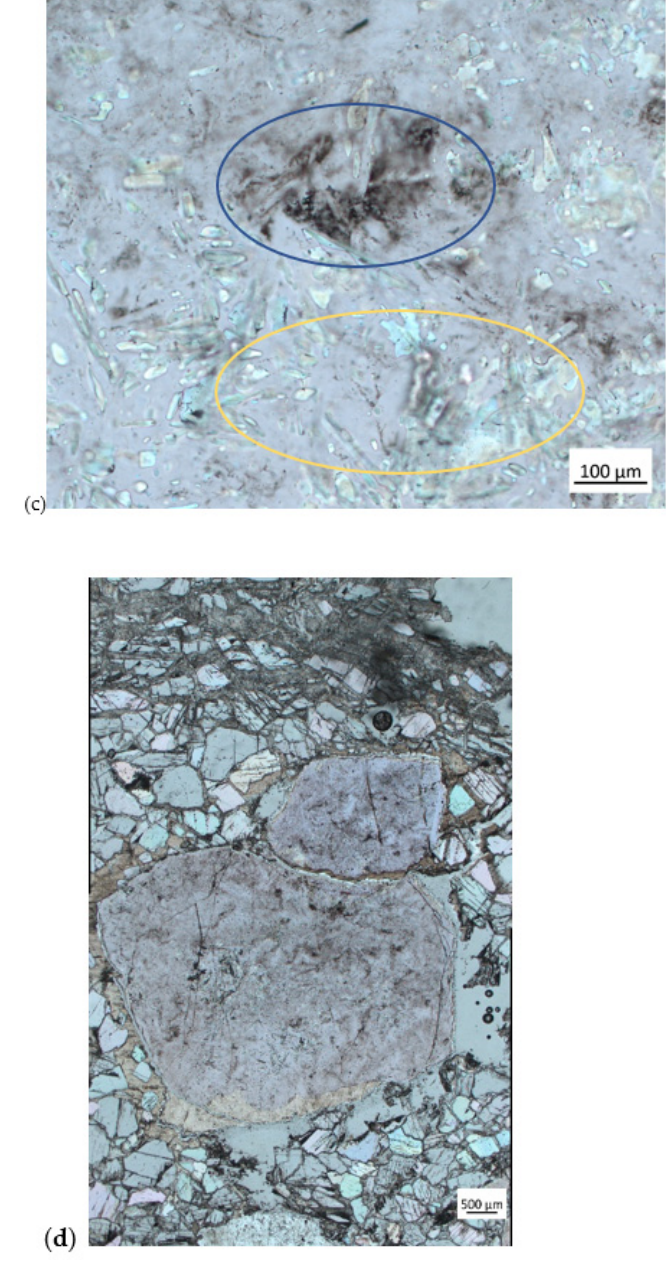
Figure 11. ( a ) petrographic thin section with disordered graphite (red circle), anhydrite (green star), and bukovskyite (orange circle) inclusions incorporated into the quartz. Inside the host rock there are also ( b ) gypsum crystals (blue ovals); ( c ) graphite (blue ovals) and anhydrite (yellow ovals) inclusions clusters (20 × ); and ( d ) dark spots, all of graphite clusters (2.5 × ). In Figure 12 we report the Raman analysis spectra of four points (red color), which highlight the presence of anhydrite, bukovskyite, and disordered graphite, together with the host quartz, and the relative RRUFF database spectra (grey color). According to [28], the bending of Si–O–Si bond angles and twisting are localized below 300 cm − 1 (126, 206, and 263 cm − 1 in Figure 12c), and the bending of O–Si–O angles are localized in the region 350–500 cm − 1 (395, 465cm − 1 in Figure 12c). According to [29,30], in the sulfate group vibrational modes of Ca-O bonds appear in Raman spectra in the region below 400 cm − 1 . In Figure 12 the bands at 140 and 160 cm − 1 are due to the vibration of